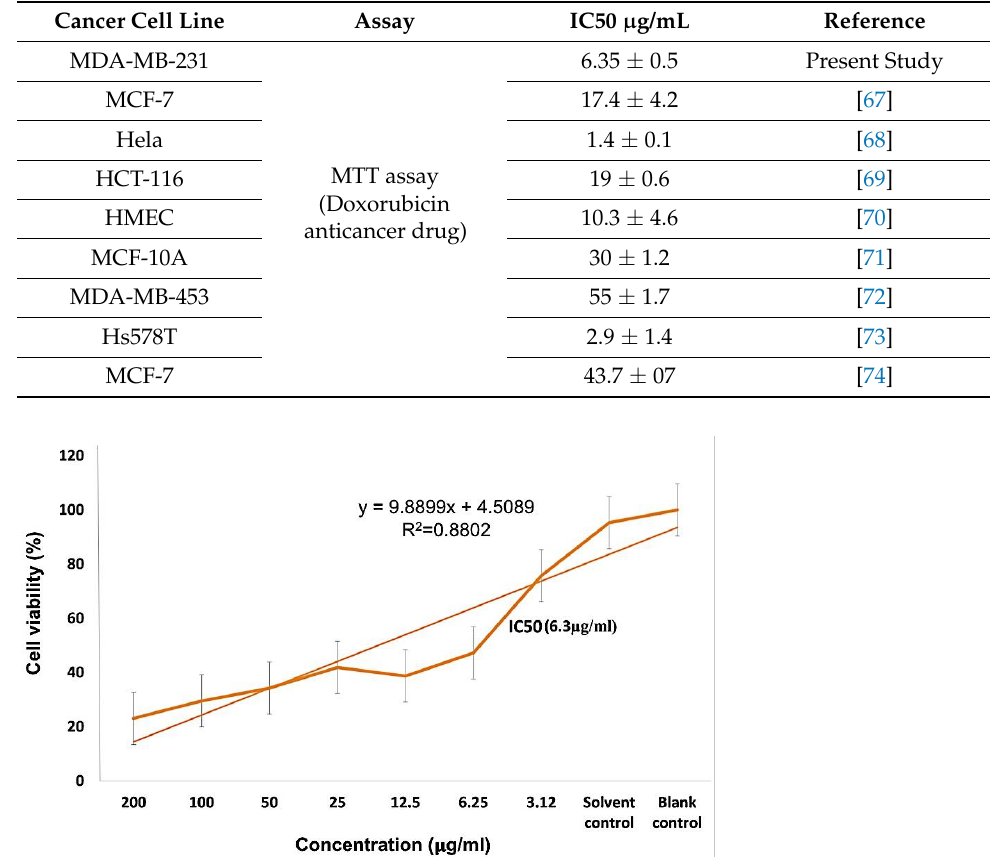
Figure 11. DOX/PEG-ZnO-NPs sample of metal oxide % cell viability and IC 50(6.3 µg/mL) analysis with a concentration range of 0–200 µg/mL